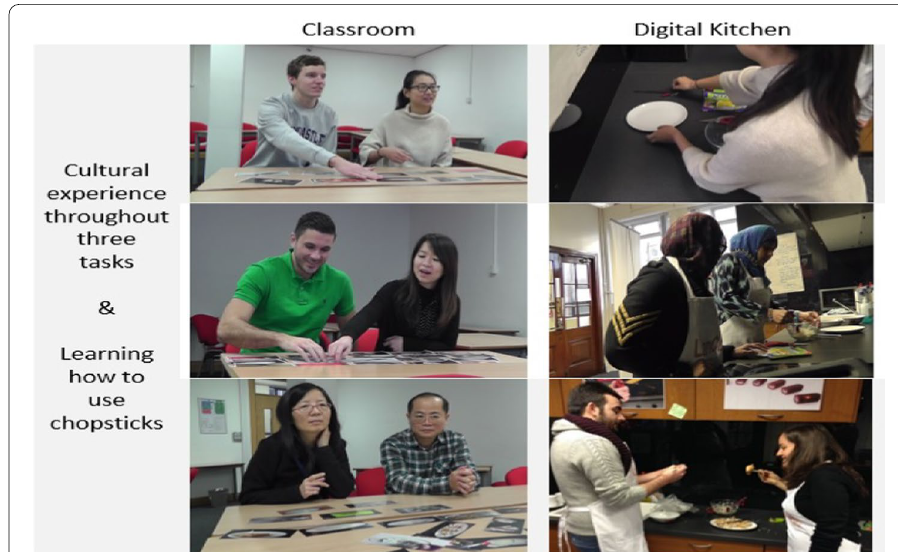
Fig. 3 Classroom versus digital kitchen